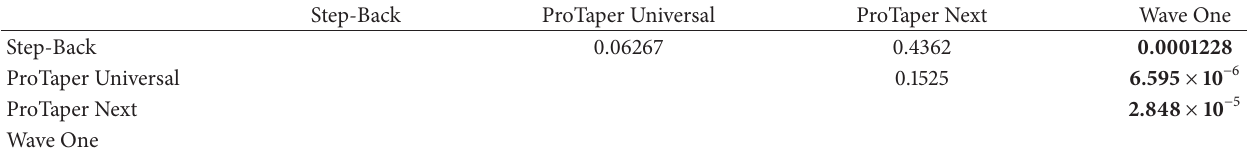
Table 1: 𝑡 -test showed the presence of statistically significant differences ( 𝑝 < 0.05 ) at coronal third.